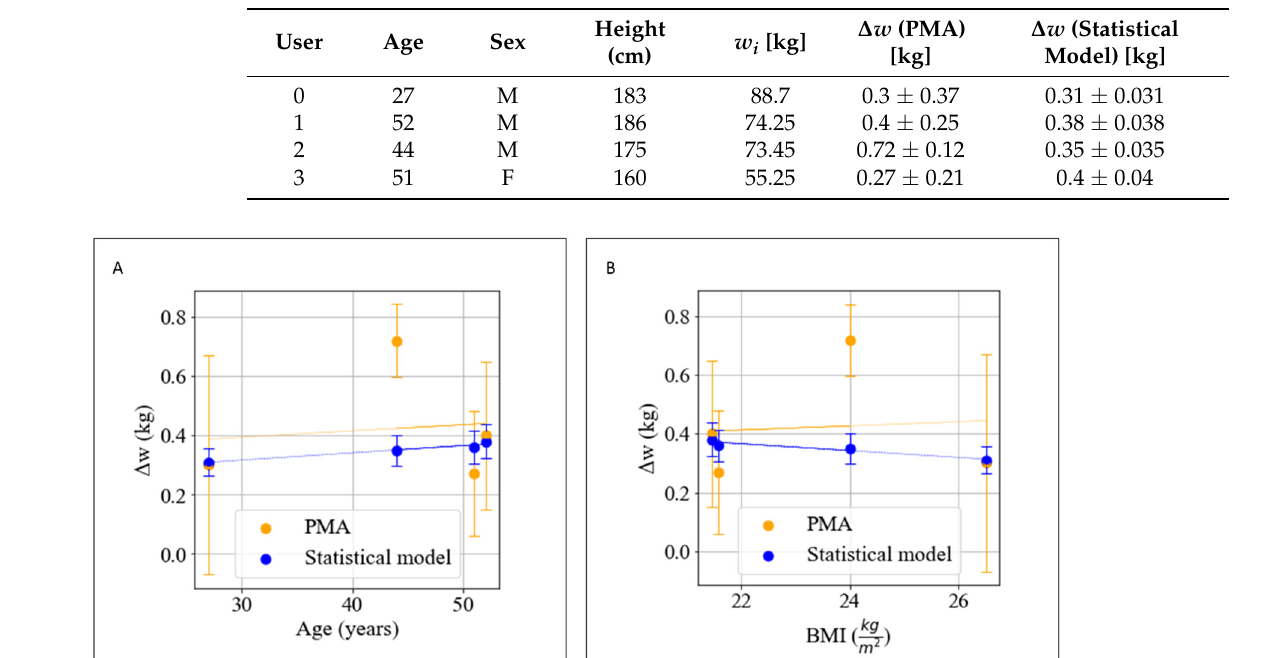
Table 4. Comparison of weight predictions between statistical and data-driven models (PMA).